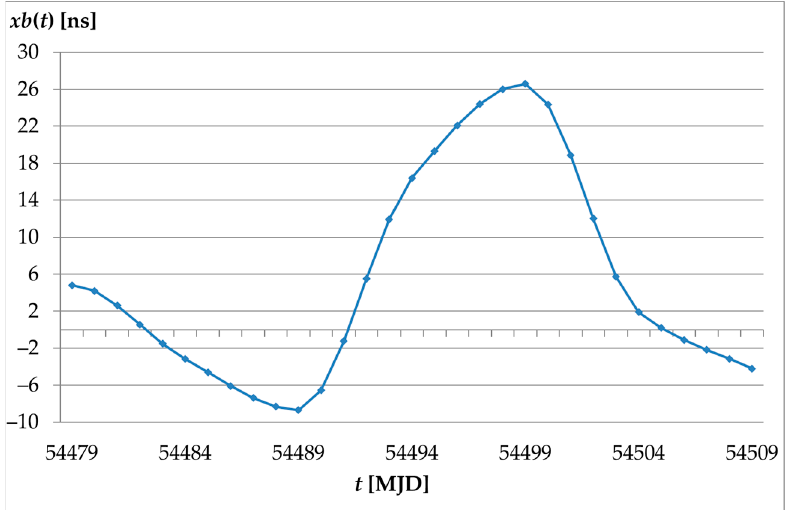
Figure 7. Values of xb ( t ) deviations for a period of one month (from MJD 54479 to MJD 54509) after interpolation with the PCHIP function.